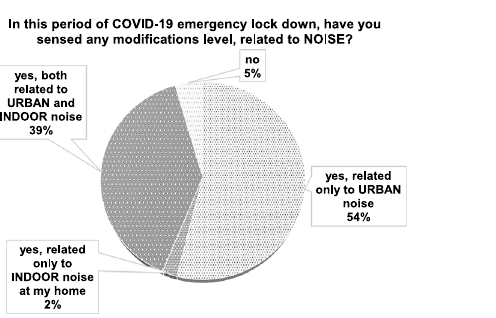
Figure 8. Italian results: comparison between outdoor and indoor noise variation future intention.